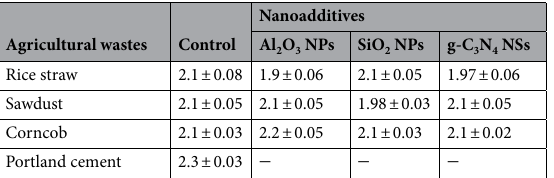
Table 6. The densities (g/cm 3 ) of mortar cubes after casting and demolding.